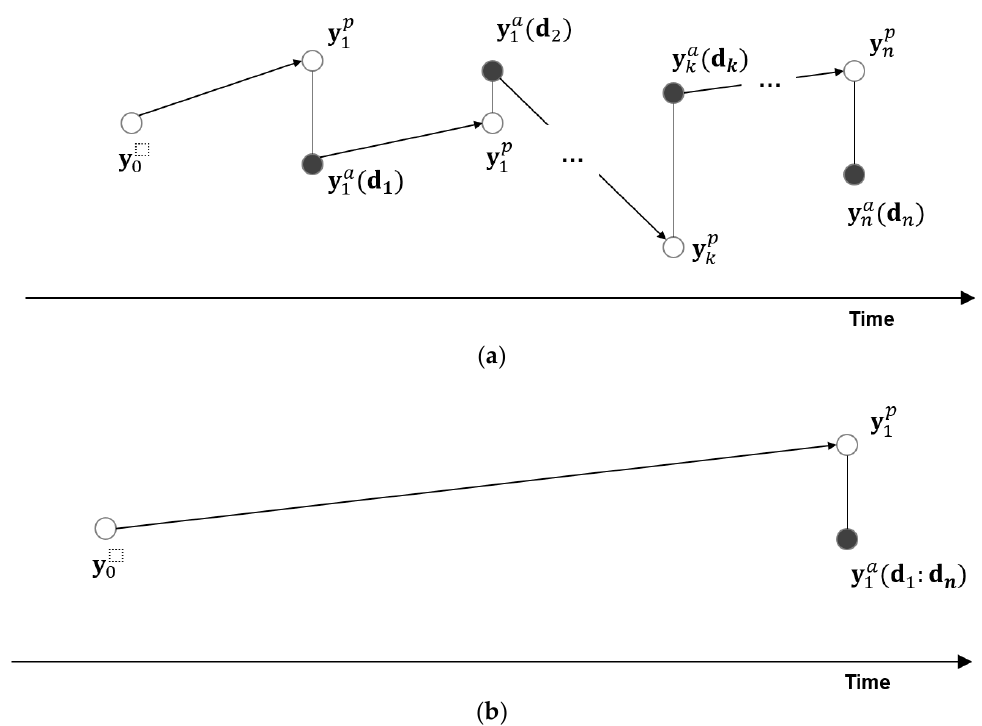
Figure 2. Comparison of sequence between ( a ) EnKF, and ( b ) ES: y and d mean a state vector and an observation vector, respectively. Superscripts p and a denote ‘prediction’ and ‘assimilation’, which processes are represented by arrow and solid line. The subscript number is the time step for the process. d 1 : d n means an observation vector, which consists of observations from the 1st to the n -th time steps. An open circle means a prediction step, while a dark circle is an assimilation stage.